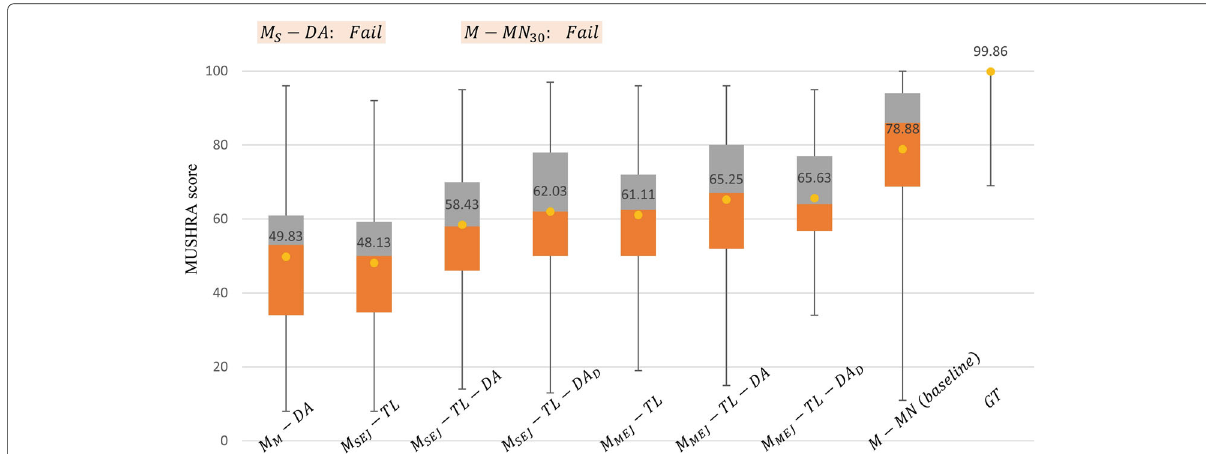
Fig. 10 MUSHRA naturalness scores for all single-speaker and multi-speaker models. M-MN: TTS model trained with 12 h of target language data; M-MN 30 : TTS model trained from scratch with only 30 min of target language data; M SEJ : sequentially trained single-speaker model; M MEJ : simultaneously trained multi-speaker model; TL: cross-lingual transfer learning; DA: data augmentation; DA D : data augmentation method with additional